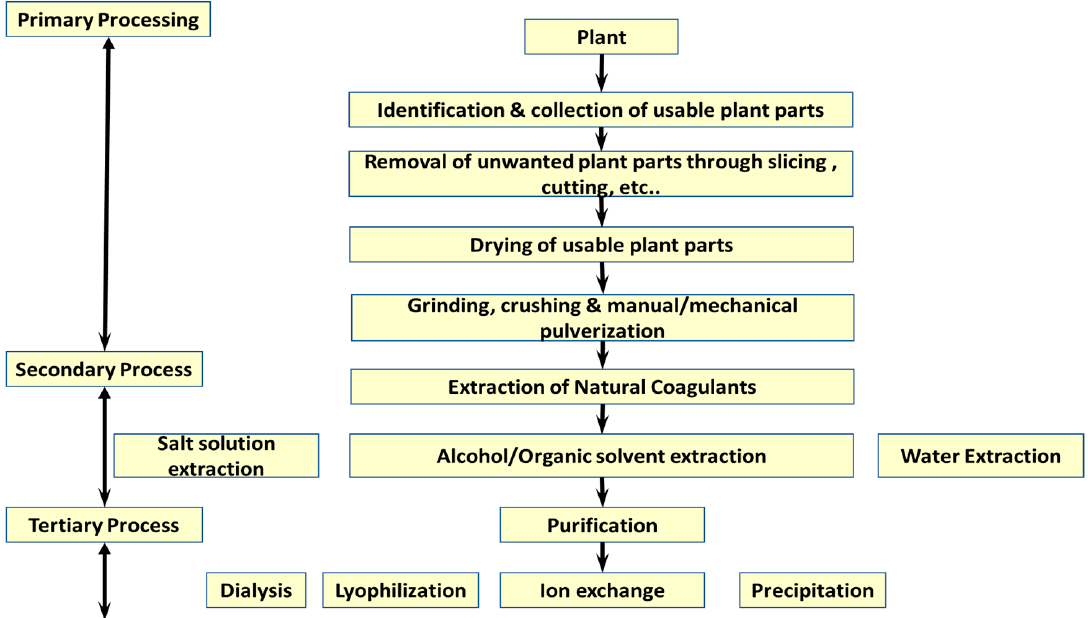
Figure 3. Schematic representation of natural coagulants’ extraction process.